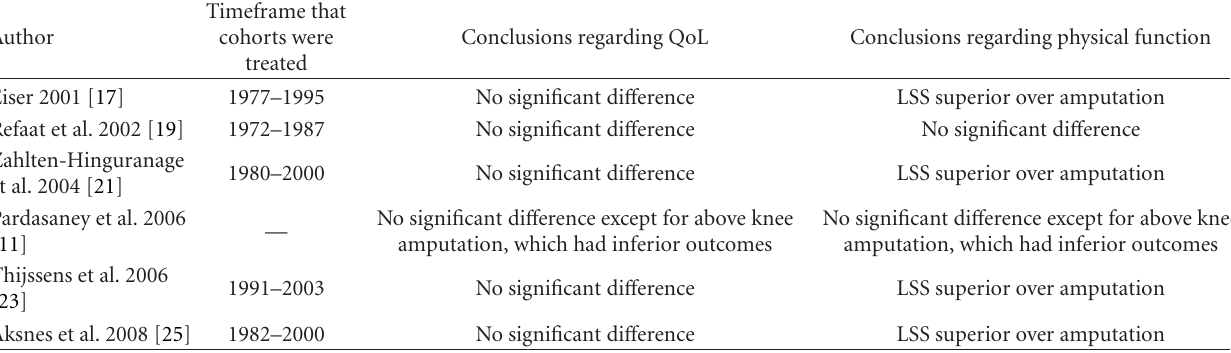
Table 4: Summary of studies comparing limb sparing surgery with